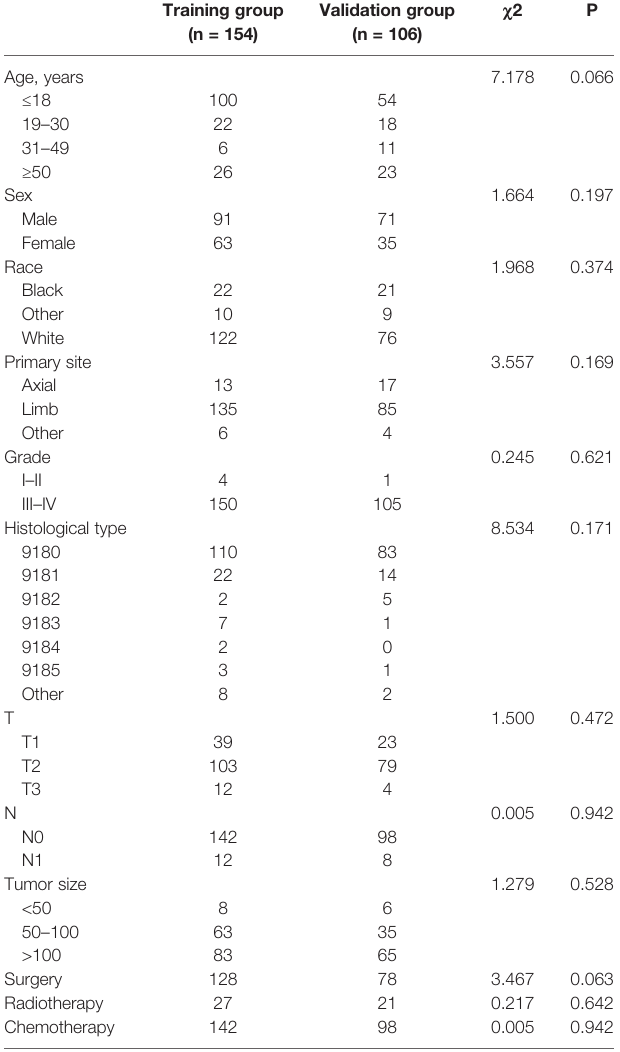
TABLE 3 | Baseline clinical characteristics of patients diagnosed as osteosarcoma with DM. Training group (n =